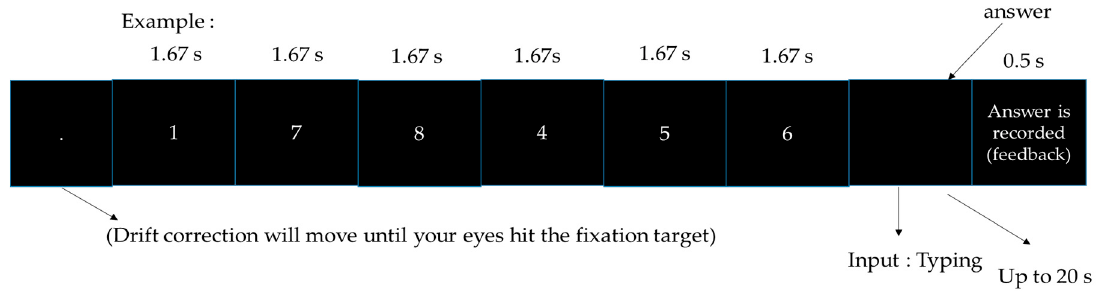
Figure 2. Forward digit span.